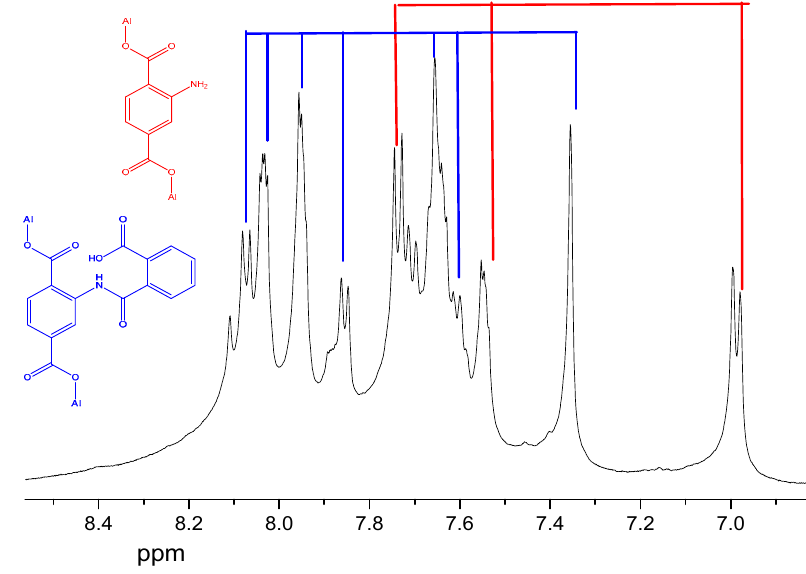
Figure 2. 1 H NMR spectrum of MIL-53-NH-Ph in DCl + DMSO-d 6.